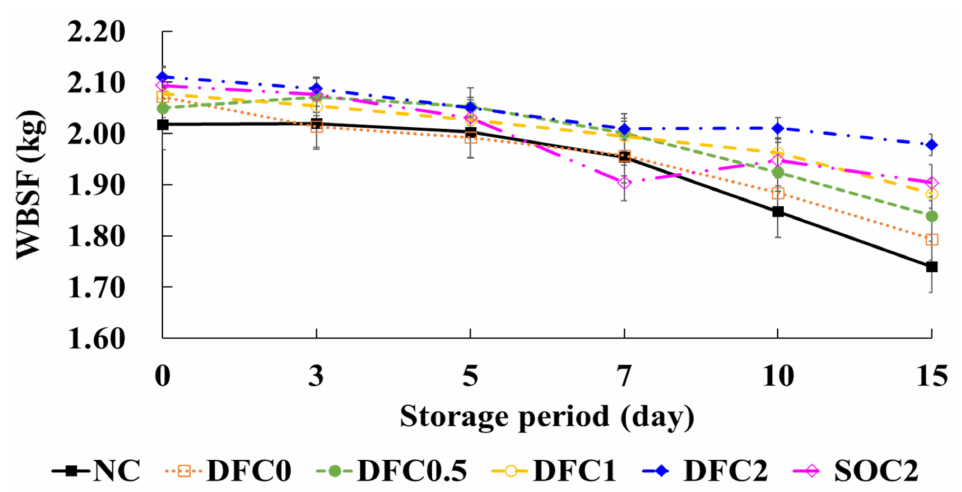
Figure 2. Warner–Bratzler shear force (WBSF) of coated chicken meat during storage at 4 ± 1 ◦ C for 15 days. NC, non-coated; DFC0, coated with duck fat, with no chitosan; DFC0.5, coated with duck fat and 0.5% chitosan; DFC1, coated with duck fat and 1% chitosan; DFC2, coated with duck fat and 2% chitosan; SOC2, coated with soybean oil and 2% chitosan. The error bars indicate SD ( n = 3).